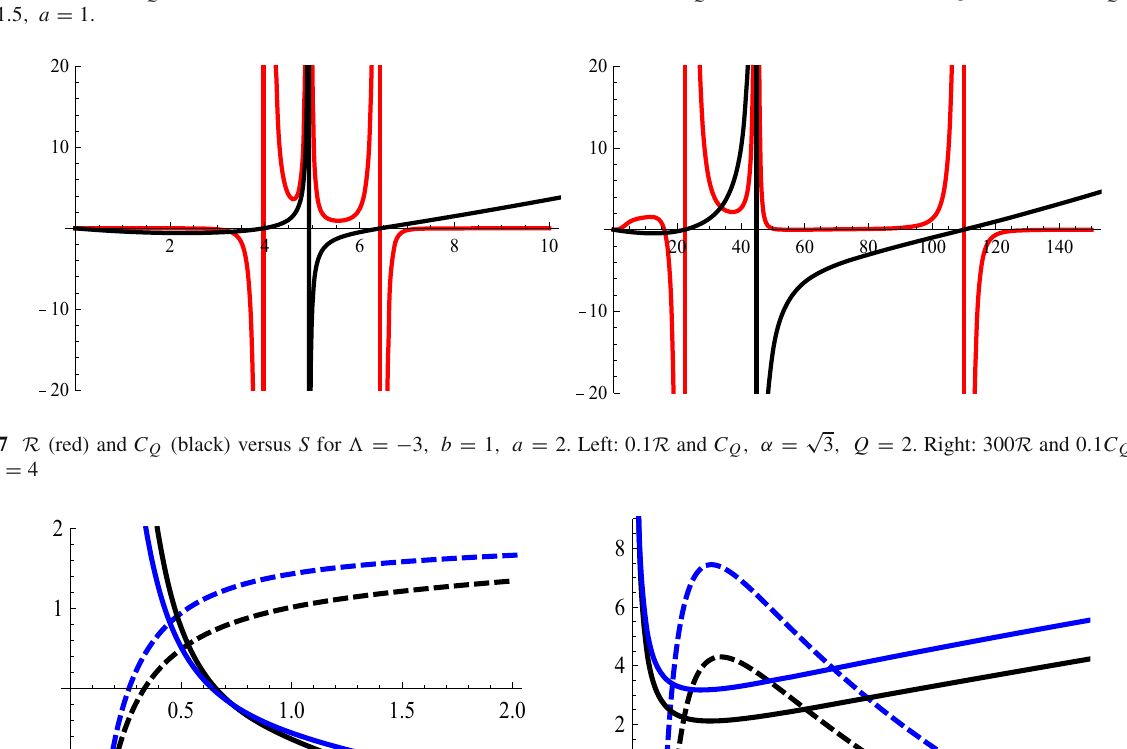
Fig. 8 G ( r + ) and T ( r + ) versus r + for (cid:11) = − 3 , Q = 1, Eqs. (3.1) and (5.2). Left: 2 T ( dashed ) and G ( continues ) , a = 1 , b = 1 . 5 , α = 0 . 65 ( black ), 0 . 8 ( blue ) . Right: 30 T ( dashed ) and G ( continues ) , a = 1 . 5 , b = 1 , α = 1 . 3 ( black ), 1 . 4 ( blue )